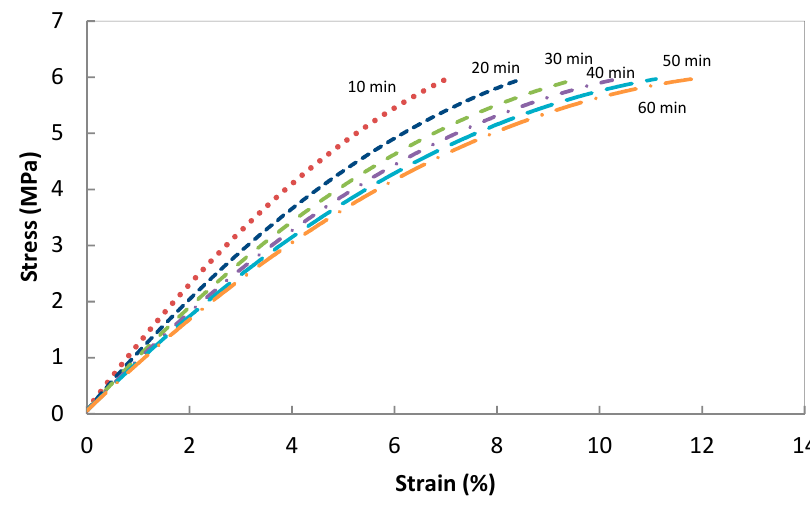
Figure 2. Isochronous curves obtained from creep curves as shown in Figure 1.